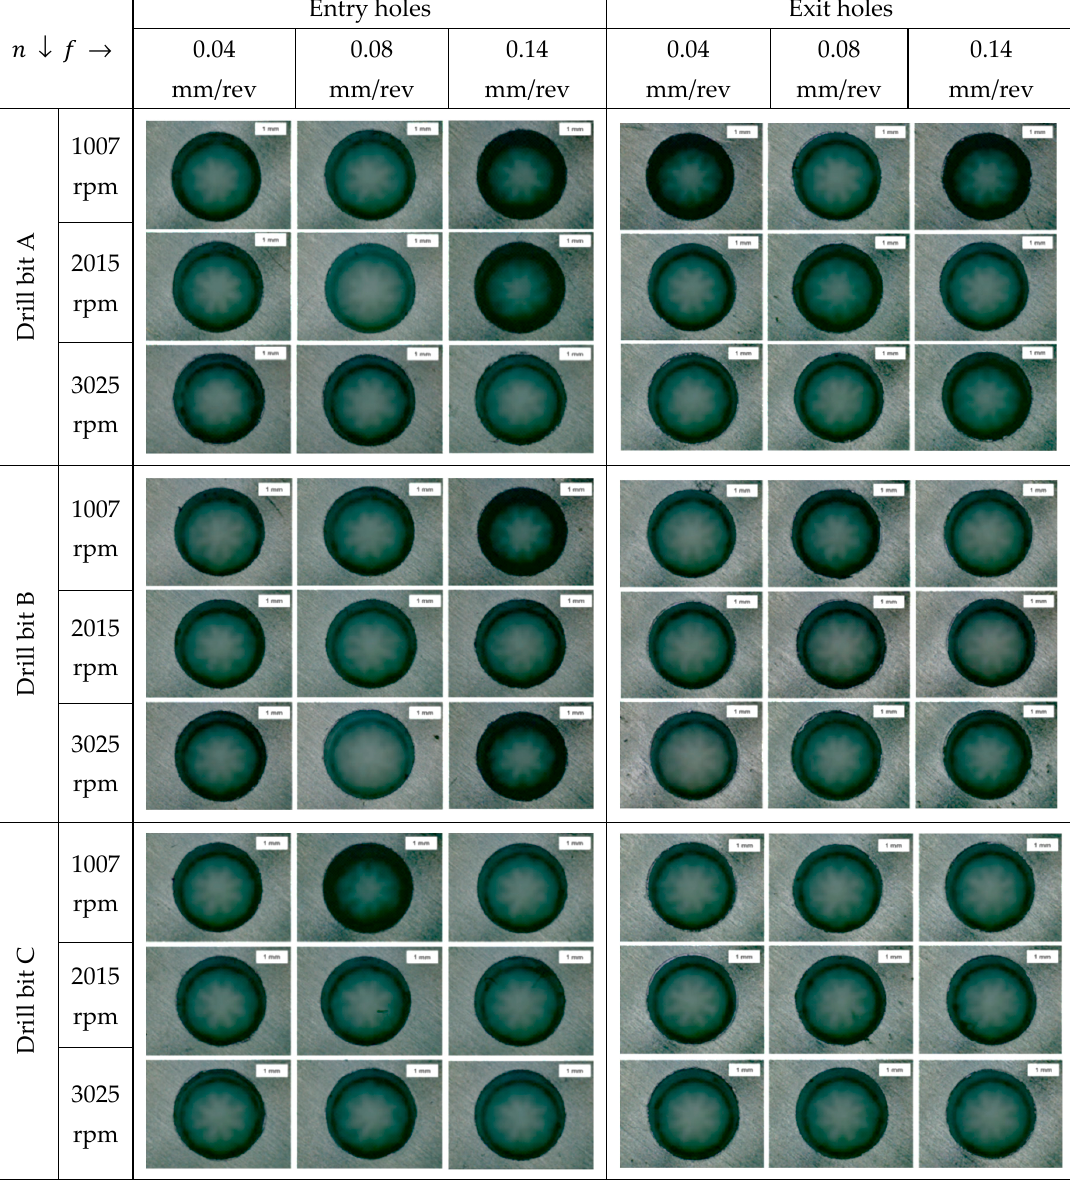
Figure 3. Hole images from uncoated carbide drills [18] .